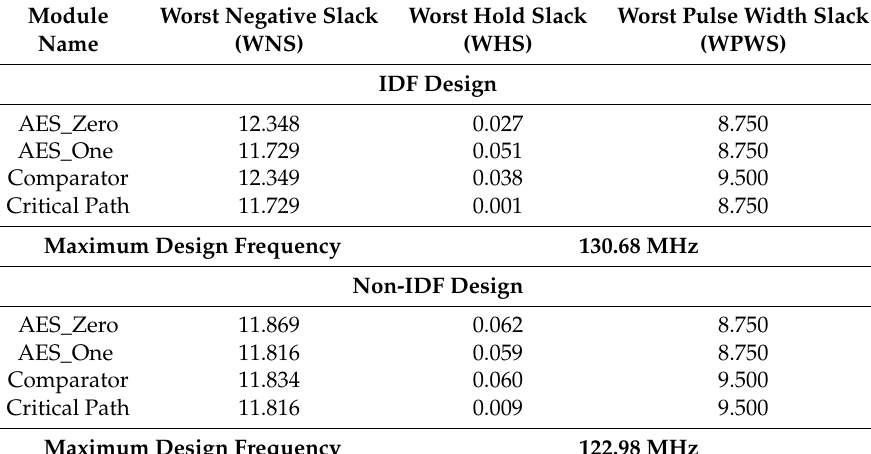
Table 5. Timing Constraints Summary in nanoseconds (ns).